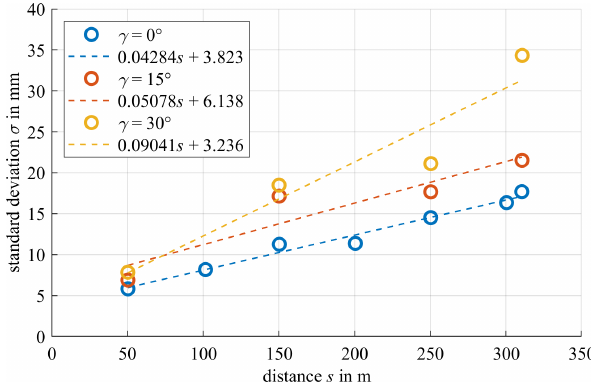
Figure 5. Standard deviation of the measured distance to a white- board over the working distance s for different board tilt angles γ (circles). A line is fitted through the points (dotted lines).